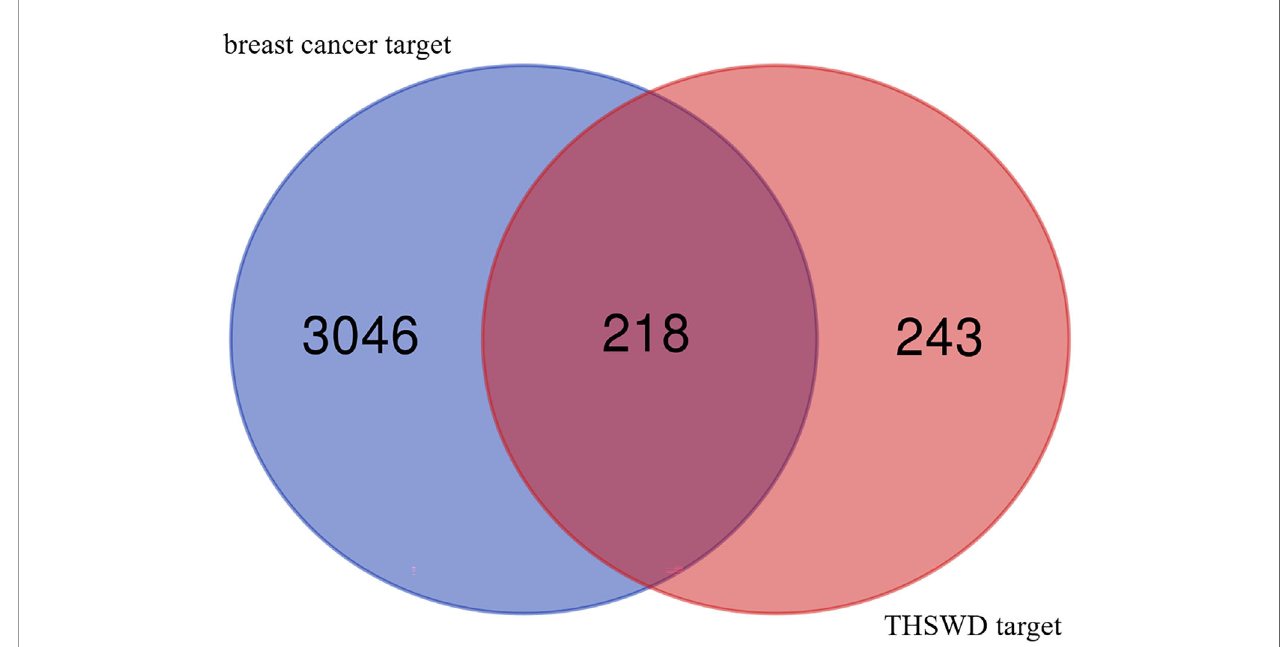
FIGURE 1 | Venn diagram of component target and disease